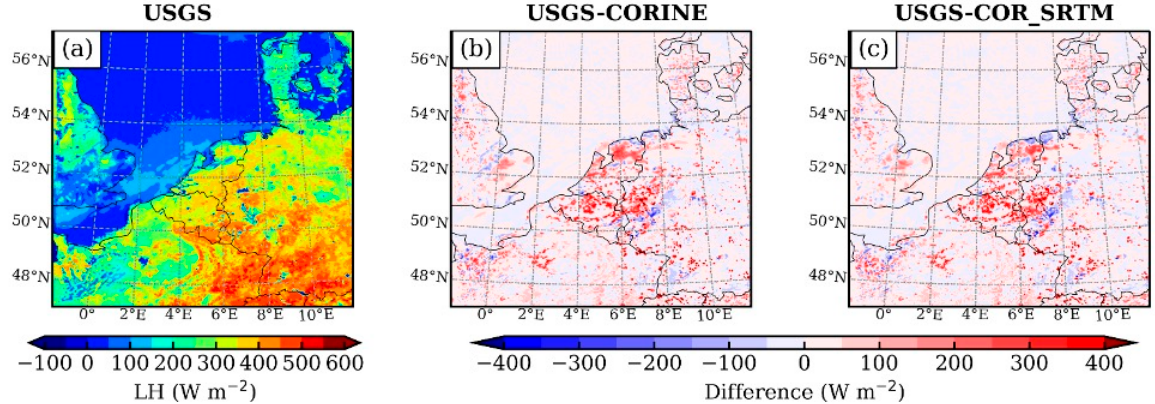
Figure 5. Latent heat fluxes according to ( a ) USGS, and differences in LH between ( b ) USGS and Corine and ( c ) USGS and Corine + SRTM at 12 UTC on 18 August 2011.